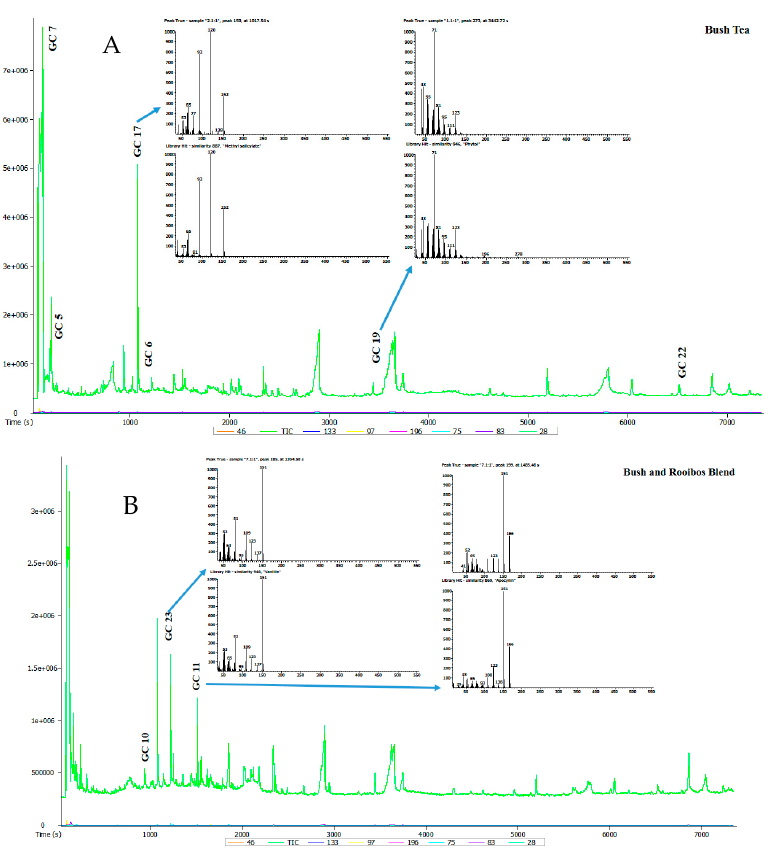
Figure 2. (A, B) Typical total ion chromatogram of the volatile compounds in selected tea samples. Figure 2. ( A,B ) Typical total ion chromatogram of the volatile compounds in selected tea